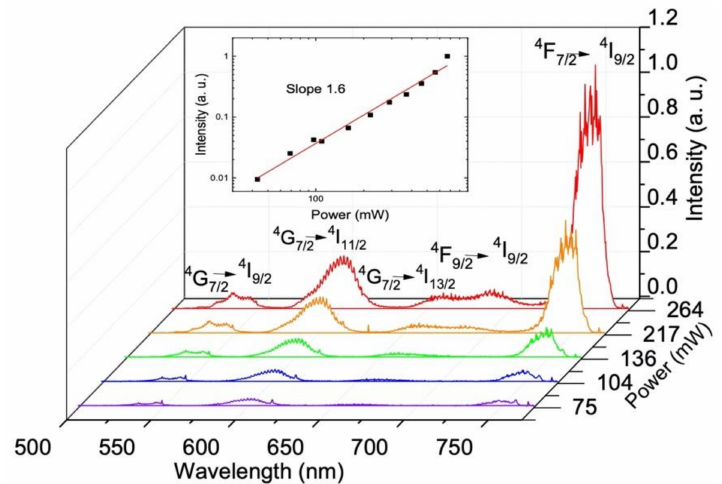
Figure 7. Upconversion emission spectra of Nd 3+ ions inside a microsphere obtained at different pump powers. WGM resonances appear superimposed on these emissions. Inset: dependence of the upconversion emission at 579 nm with the excitation